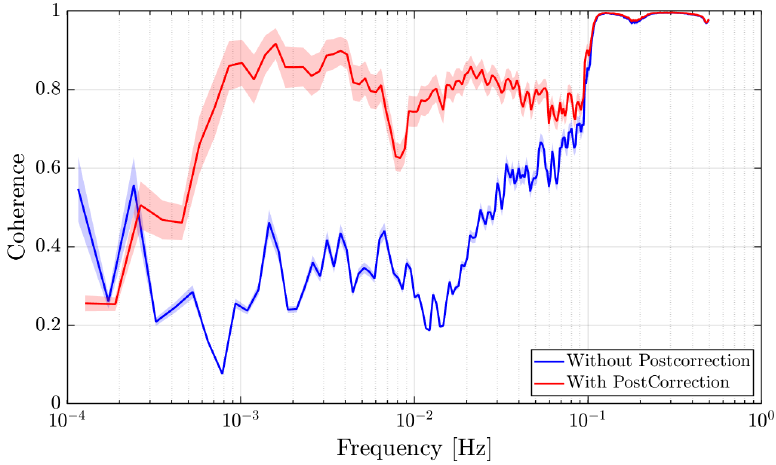
Figure 12. The magnitude of the coherence between our postcorrected resonator data and seismome- ter data both before and after removing environmental noises. It can be seen that by removing temperature, pressure, and laser frequency fluctuations from the resonator data, the coherence above 1mHz improves significantly. The shaded areas represent the estimated error bars of the spectra.